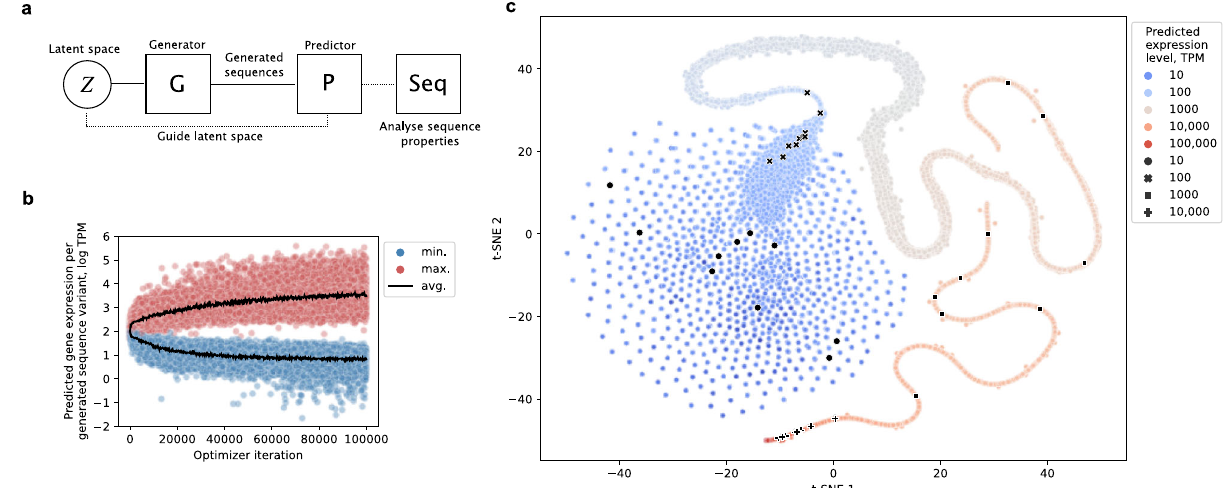
Fig. 3 | Predictor-guided generator optimization enables gene-speci fi c navi- gationoftheregulatorysequence-expressionlandscape.a Schematicdepiction of the procedure to optimize the generator using a trained predictor 7 , which introduces codon frequency information into the generative approach and explores the input latent space of the generator to produce sequence variants across the whole range of gene expression, providing precise navigation of the gene regulatory sequence-expression landscape. b Predicted expression levels of generated sequence variants across optimization iterations set to either maximize (red)or minimize (blue)expression levels ( n =64,000). Black lines denote average